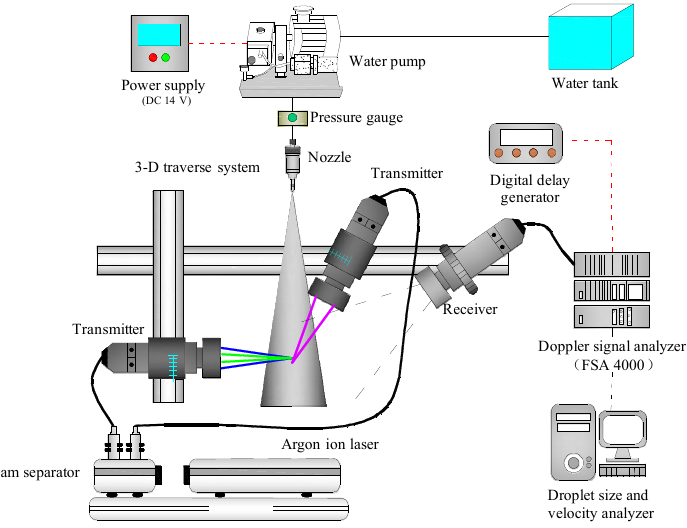
Figure 2. Schematic diagram of the atomizing test system.